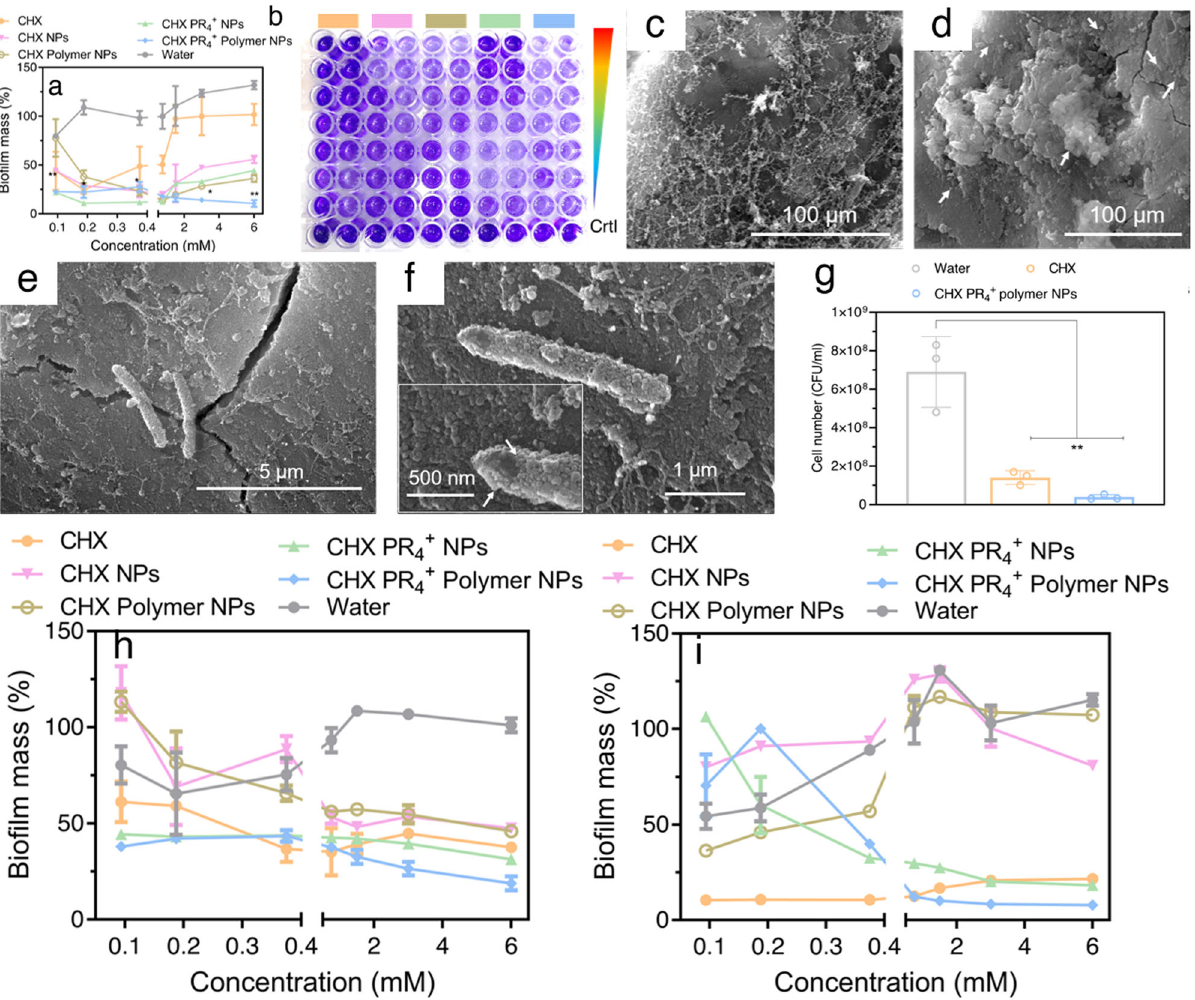
Fig. 5 Antibio fi lm properties of CHX PR 4 + polymer NPs against mature bio fi lms (48-h old). Bio fi lm a dispersion and b the corresponding plate digital photographs of the wells; the top-most well is the control with the colors on the top representing sample ID, the wedge gradient indicates decreasing concentrations. Here, two-way ANOVA was performed, and p values < 0.1, and 0.01 are indicated by * and **, respectively. Bio fi lm and EPS inhibition for bio fi lms grown on human tooth c control (water-treated) and d NP-treated samples. The images were acquired at the same magni fi cation; e few surviving bacteria in the treated sample and f the attachment of the NPs to the bacteria are represented in the higher magni fi cation and pointed by arrows; g the colony count assay from experiment ( g ), n = 3, ordinary one-way ANOVA, p value < 0.01 is indicated with **, bio fi lm h dispersion and i inhibition as measured by the fl uorescent resazurin assay. Error bar represents mean ±